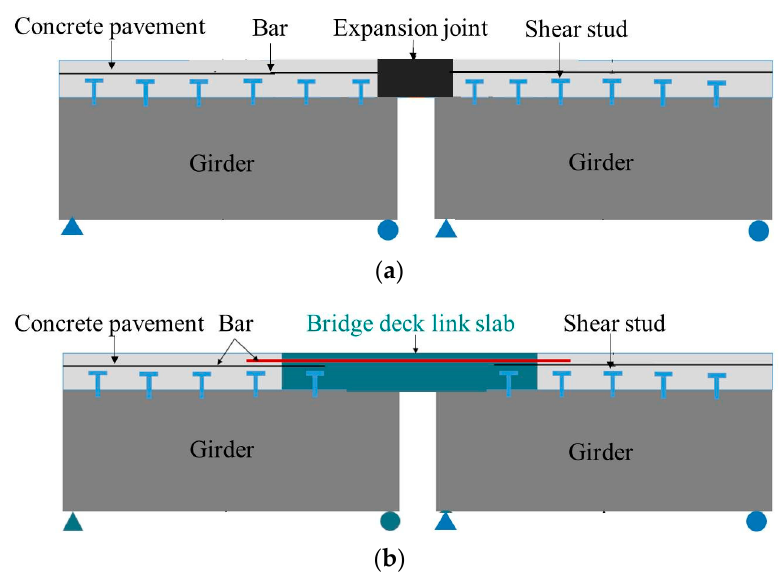
Figure 2. Schematic diagram of expansion joint and bridge deck link slab. ( a ) Expansion joint. ( b ) Bridge deck link slab. Bridge deck link